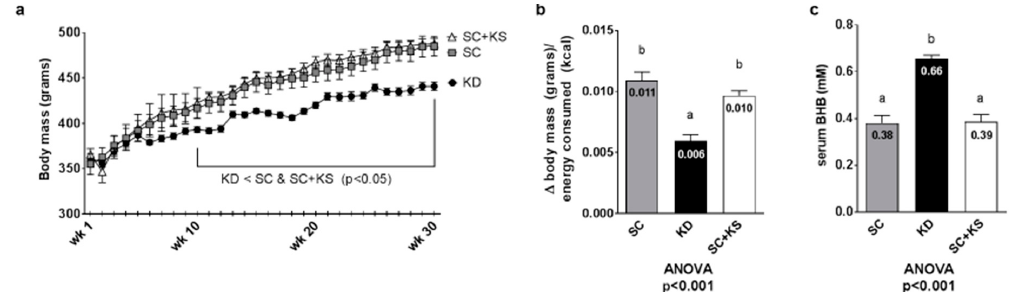
Figure 3. Change in body mass, overall feed efficiency and serum BHB in 8 month-fed rats. Legend: Body mass changes over the intervention are presented in panel ( a ), feed efficiency is presented in panel ( b ) and serum BHB levels are presented in panel ( c ). Data in panel ( a ) are presented as mean ± standard error values ( n = 7–8 per group). In panels ( b , c ), all bars are presented as mean ± standard error values and group means are indicated within each bar. In panels B and C ANOVA p -values are presented below data, and different lettering (“a” versus “b”) indicates significant between-group differences whereas shared lettering (“a” as well as “b” or “a, b”) indicates lack of significant between- group differences. Abbreviations: SC, standard chow-fed rats; KD, ketogenic diet-fed rats; SC + KS, standard chow-fed rats with supplemental sodium beta-hydroxybutyrate.